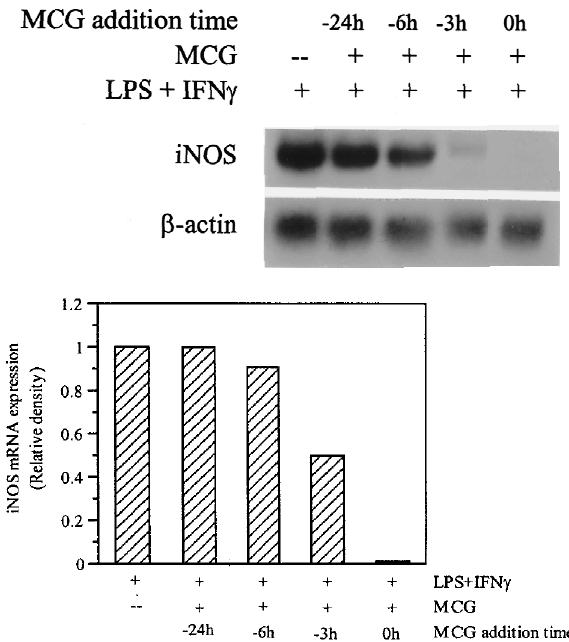
FIG. 2. Effect of pre-treatment of macrophages with MCG on iNOS mRNA expression. Macrophages (1 3 10 7 ) were cultured with MCG (2 3 10 6 mast cell equivalent) for 24, 6 and 3h prior to activation or added simultaneously with LPS + IFN g . Eighteen hours after activation, iNOS and b -actin mRNA were analysed by Northern blotting. The b -actin expression was used to normalize the data. This is repre- sentative of three